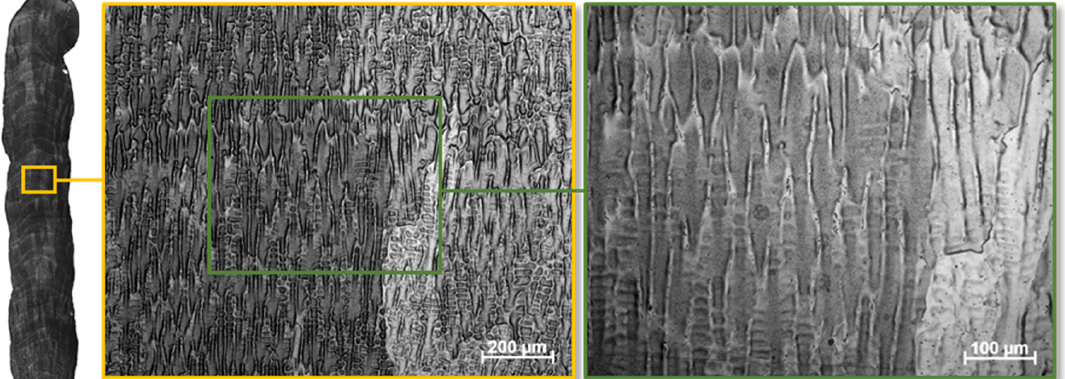
Figure 4. Microstructure of the 3DPMD component.